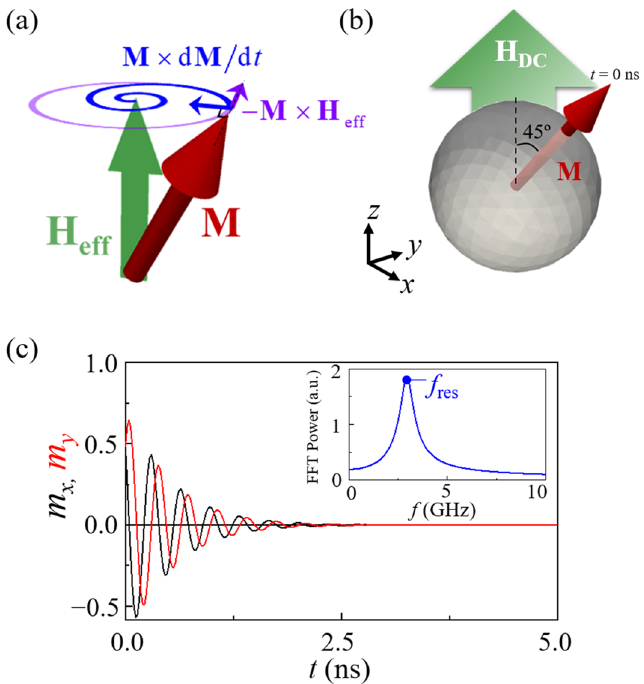
Figure 1. ( a ) Schematic illustration of two different precession motions of magnetization vector M (red) around effective magnetic field vector H eff (green) with (blue) and without (purple) damping. ( b ) Single nanosphere of diameter 2 R = 12 nm and MnFe 2 O 4 with overall magnetizations’ orientation being deviated 45° from direction (+ z) of DC magnetic field H DC . ( c ) Micromagnetic simulations of the temporal oscillations of m x and m y components of M during relaxation process under H DC = 1010 Oe for a 12 nm MnFe 2 O 4 nanosphere. The inset shows the FFT power spectrum of the m x oscillation, wherein the peak position corresponds to the intrinsic precession frequency at the given strength of H DC